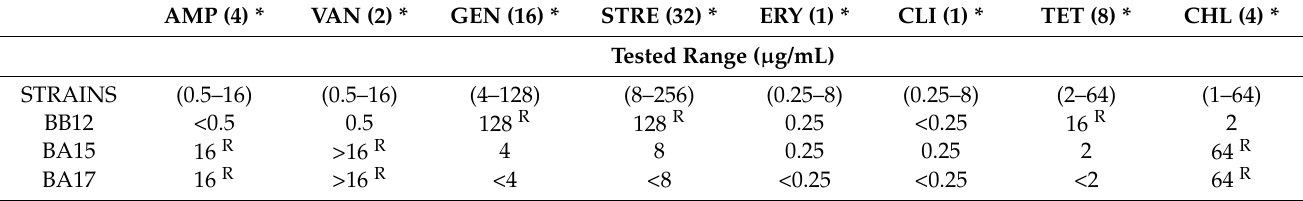
Table 4. Antibiotic resistance pattern of the Bifidobacterium asteroides BA15 and BA17